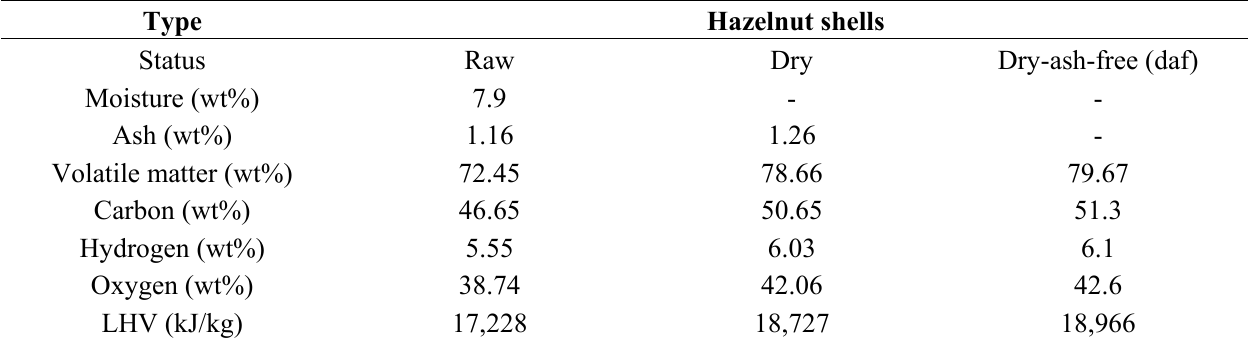
Table 3. Physical and chemical properties of biomass.